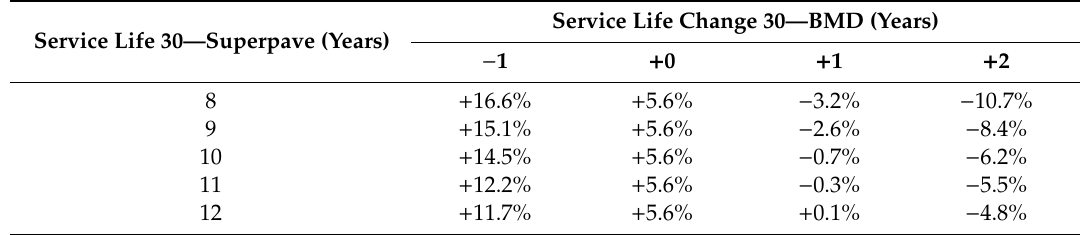
Table 4. Cost increase / reduction in 30-BMD with respect to 30-Superpave (%).